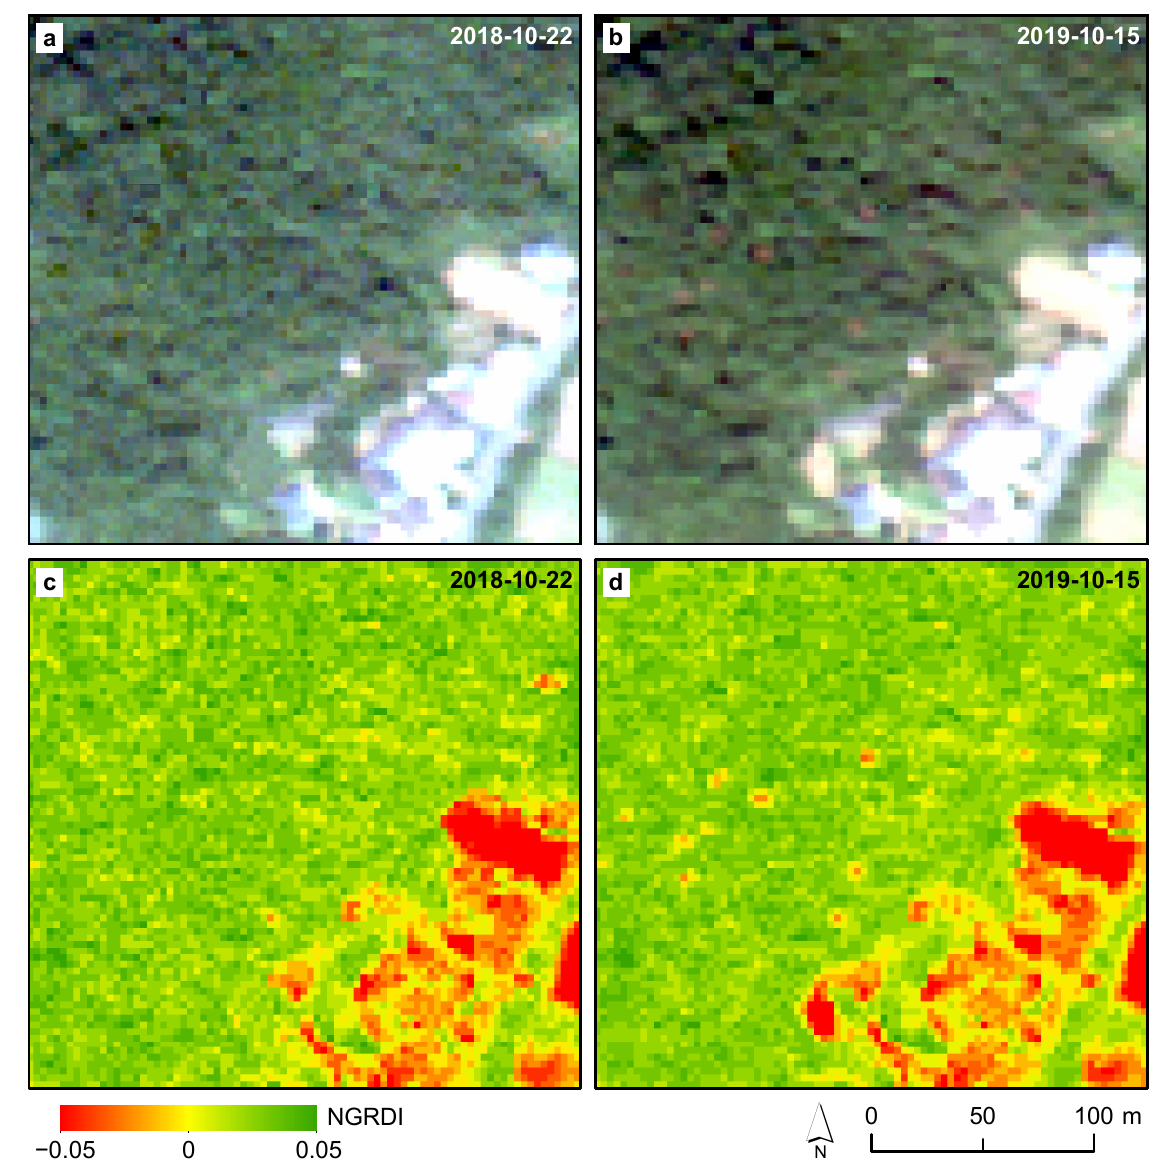
Figure 7. The true-color PlanetScope image and the NGRDI mapping at Site A on 22 October 2018 ( a , c ) and 15 October 2018 ( b , d